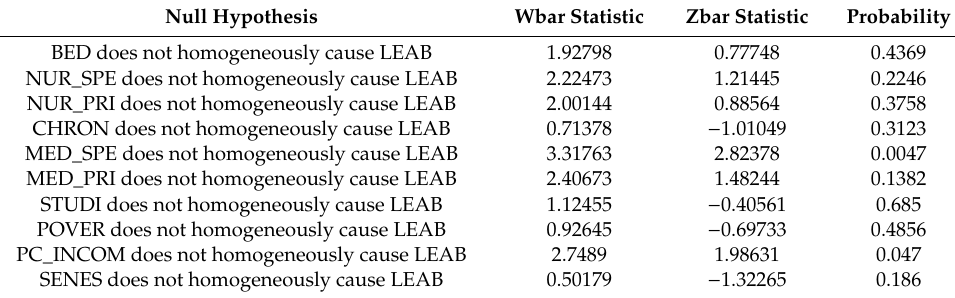
Table 4. Causality test for panel data (Dumitrescu–Hurlin version) for the analyzed sample. Source: Own